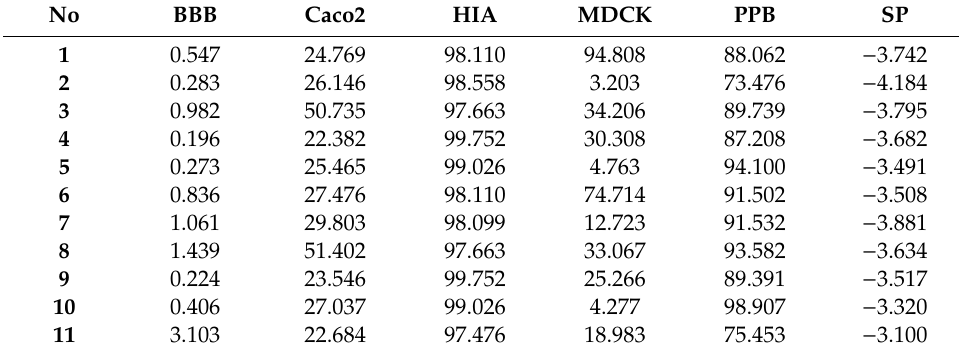
Table 4. The predicted ADME activities for 1,2,3-triazole-dipyridothiazine hybrids ( 1–10 ) and prothipendyl ( 11 )